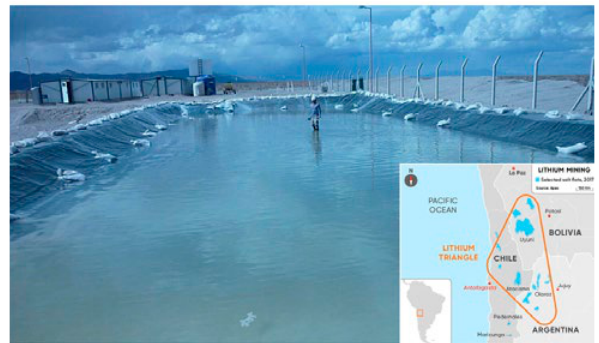
Figure 8. Lithium brine ponds in the Lithium Triangle, South America (bottom right